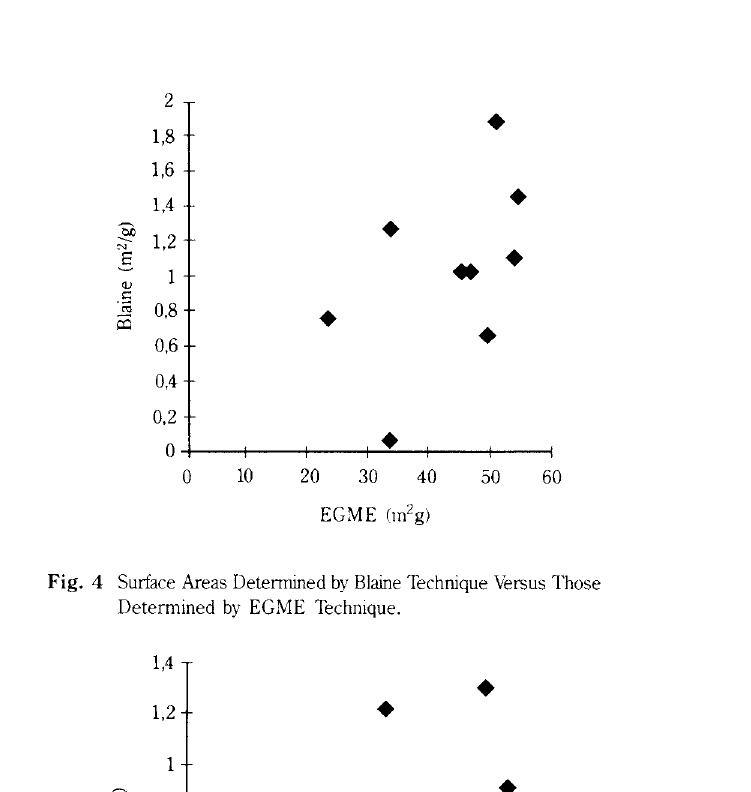
Fig. 4 Surface Areas Determined by Blaine Technique Versus Those Determined by EGME Technique.